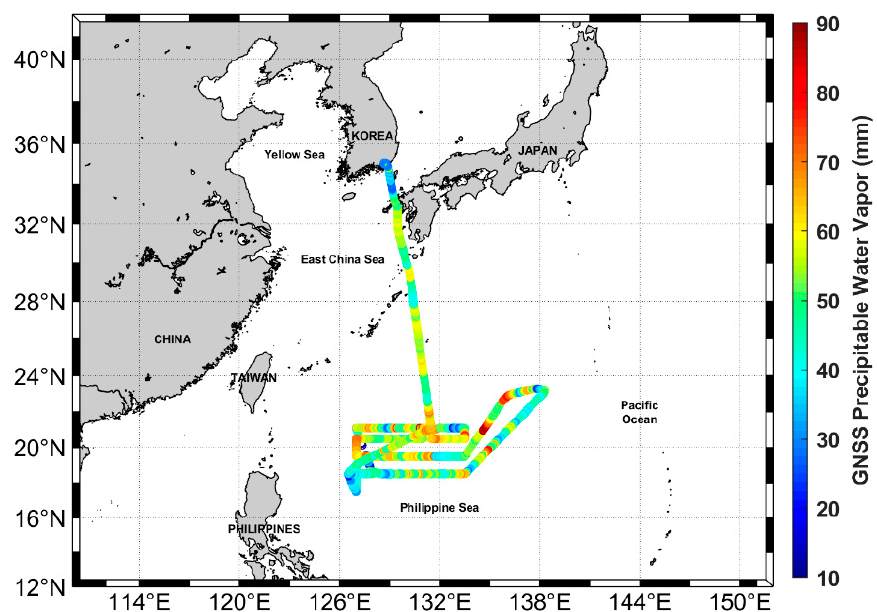
Figure 3. The PWV estimated from the shipborne GNSS observations with the vessel ISABU trajectory. The original purpose of this cruise campaign was to observe warm pool air–sea heat interaction supported to develop Typhoons. While a typhoon approaches the observation area, the vessel stayed in a safe zone of the neighboring countries.